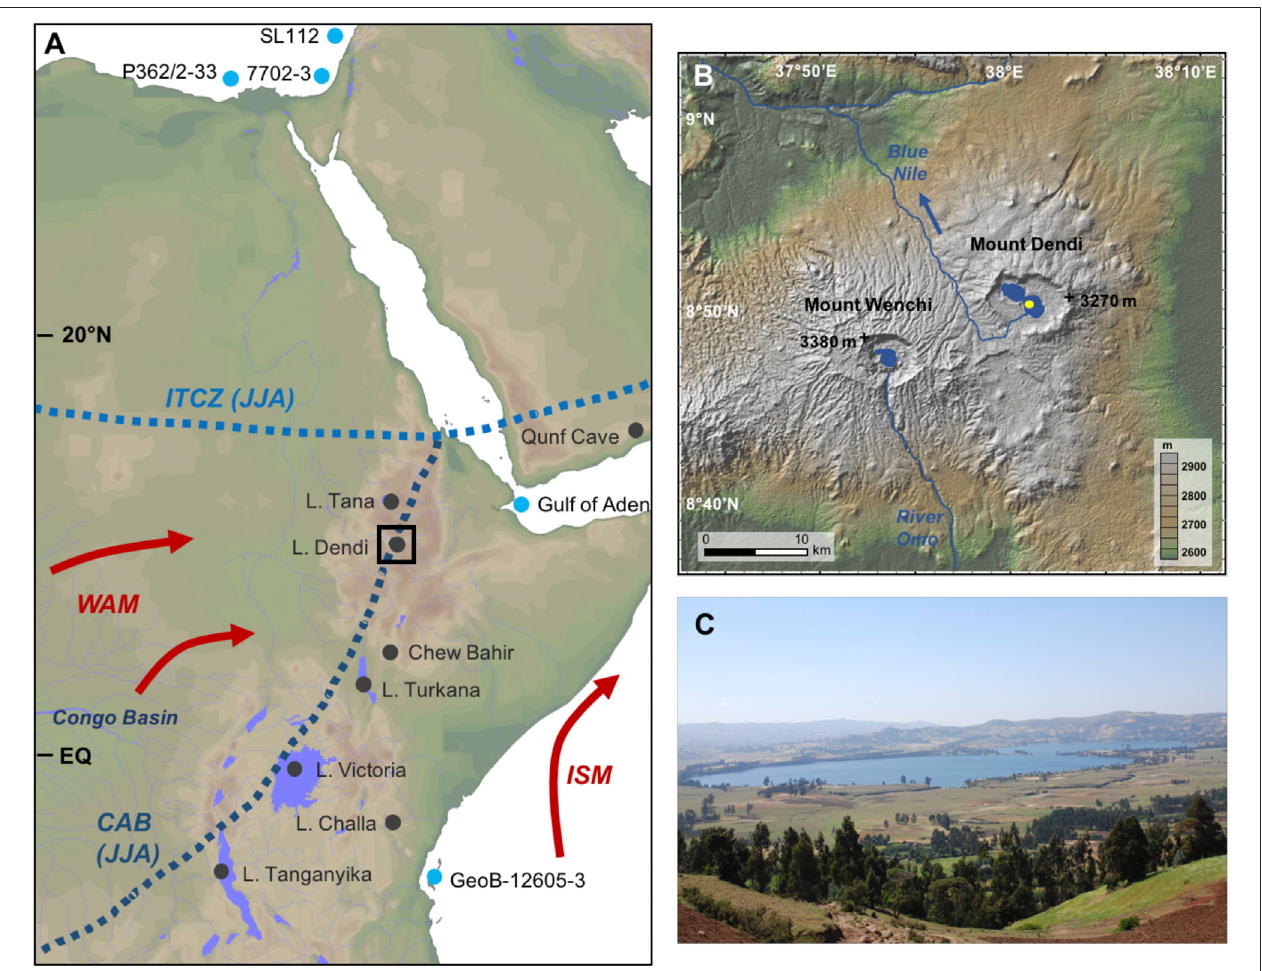
FIGURE1|(A) MapofNortheastAfricawiththepositionsofterrestrial(blackdots)andmarinearchives(bluedots)mentionedinthetext.Theblackboxdenotesthe Lake Dendi region. The approximate locations of the Intertropical convergence zone (ITCZ) and Congo Air Boundary (CAB) during northern hemisphere summer are indicated by blue dotted lines. Red arrows illustrate pathways of moisture advected from the Atlantic Ocean/Congo Basin and Indian Ocean during summer monsoon (WAM:WestAfricanMonsoon;ISM:IndianSummerMonsoon) (B) Close-upofthestudyareaonthecentralEthiopianPlateaushowingtheDendicraterandcoring location in the eastern lake (yellow dot). Lake Dendi seasonally contributes to the drainage system of the Blue Nile (indicated by blue arrow). Mount Wenchi is located about12 kmtothesouthwest. (C) ThephotographshowstheviewfromthenortheasterncraterrimonthetwobasinsofLakeDendiandthelocalvegetation,whichisat present in fl uenced by anthropogenic